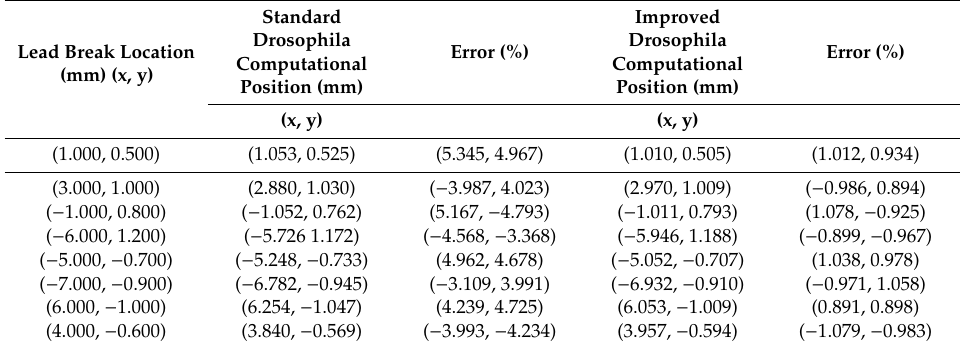
Table 4. Comparison of locations of tensile damage sources.